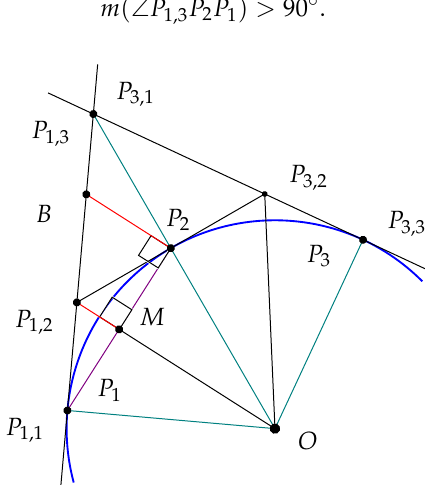
Figure 12. The intersection of circumscribed edges associated to an arc with two